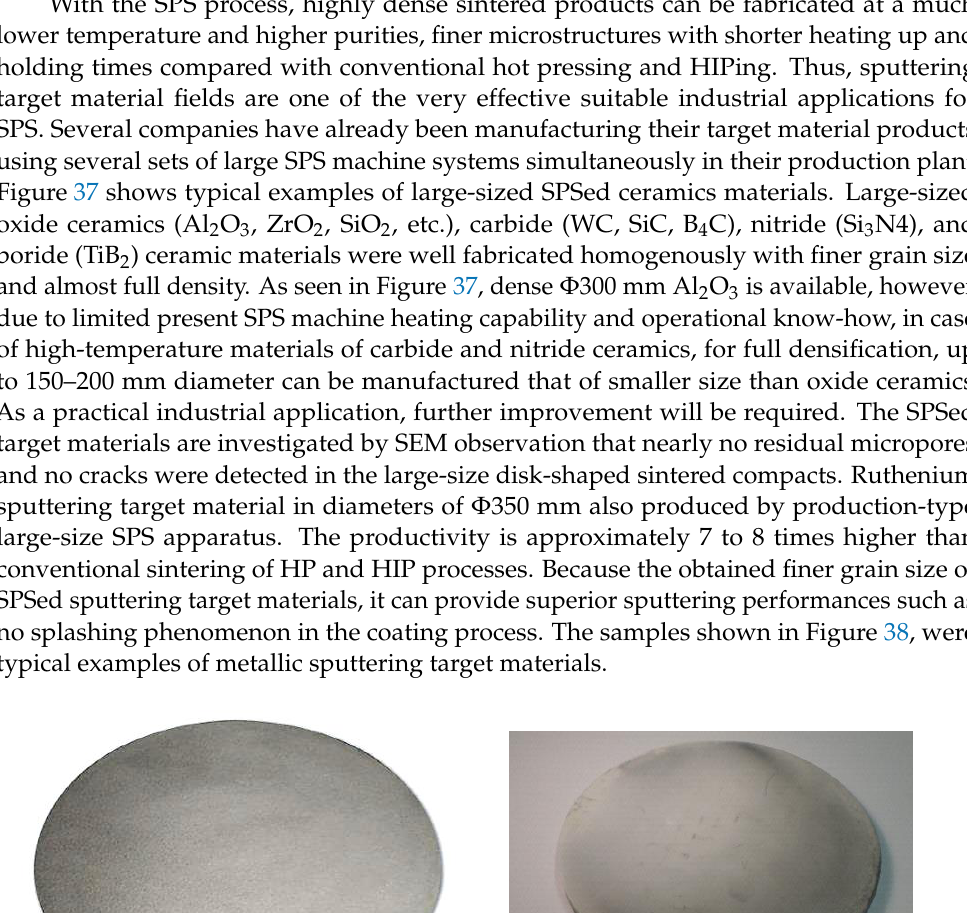
Figure 38. Example of commercialized large-size sputtering target materials: ( a ) 250 × 150 mm square-shaped metallic sputtering target; ( b ) Φ100 mm targets after mechanical finishing; and ( c ) typical working time comparison of SPS vs. HP/HIP.